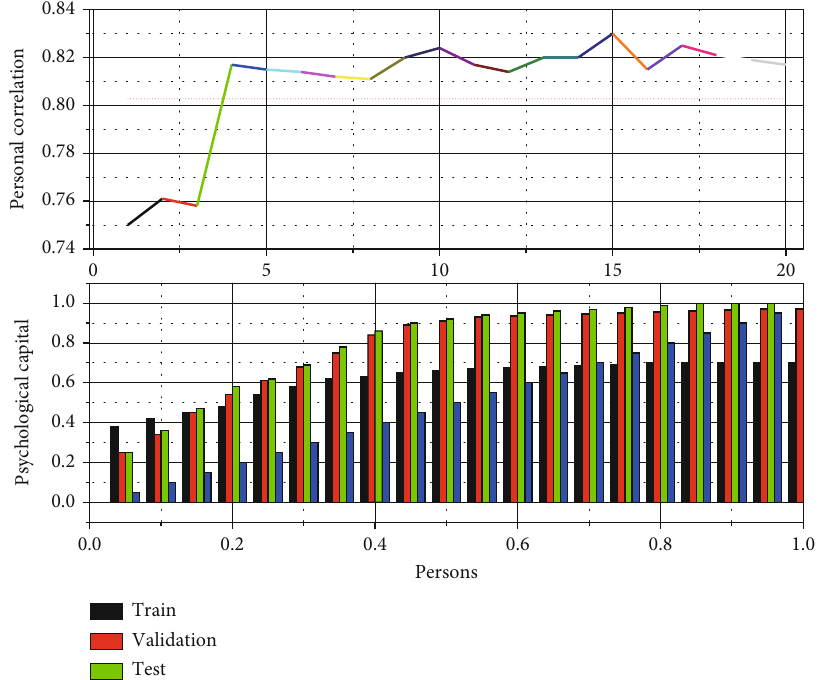
Figure 5: Correlation analysis of psychological capital and propensity to